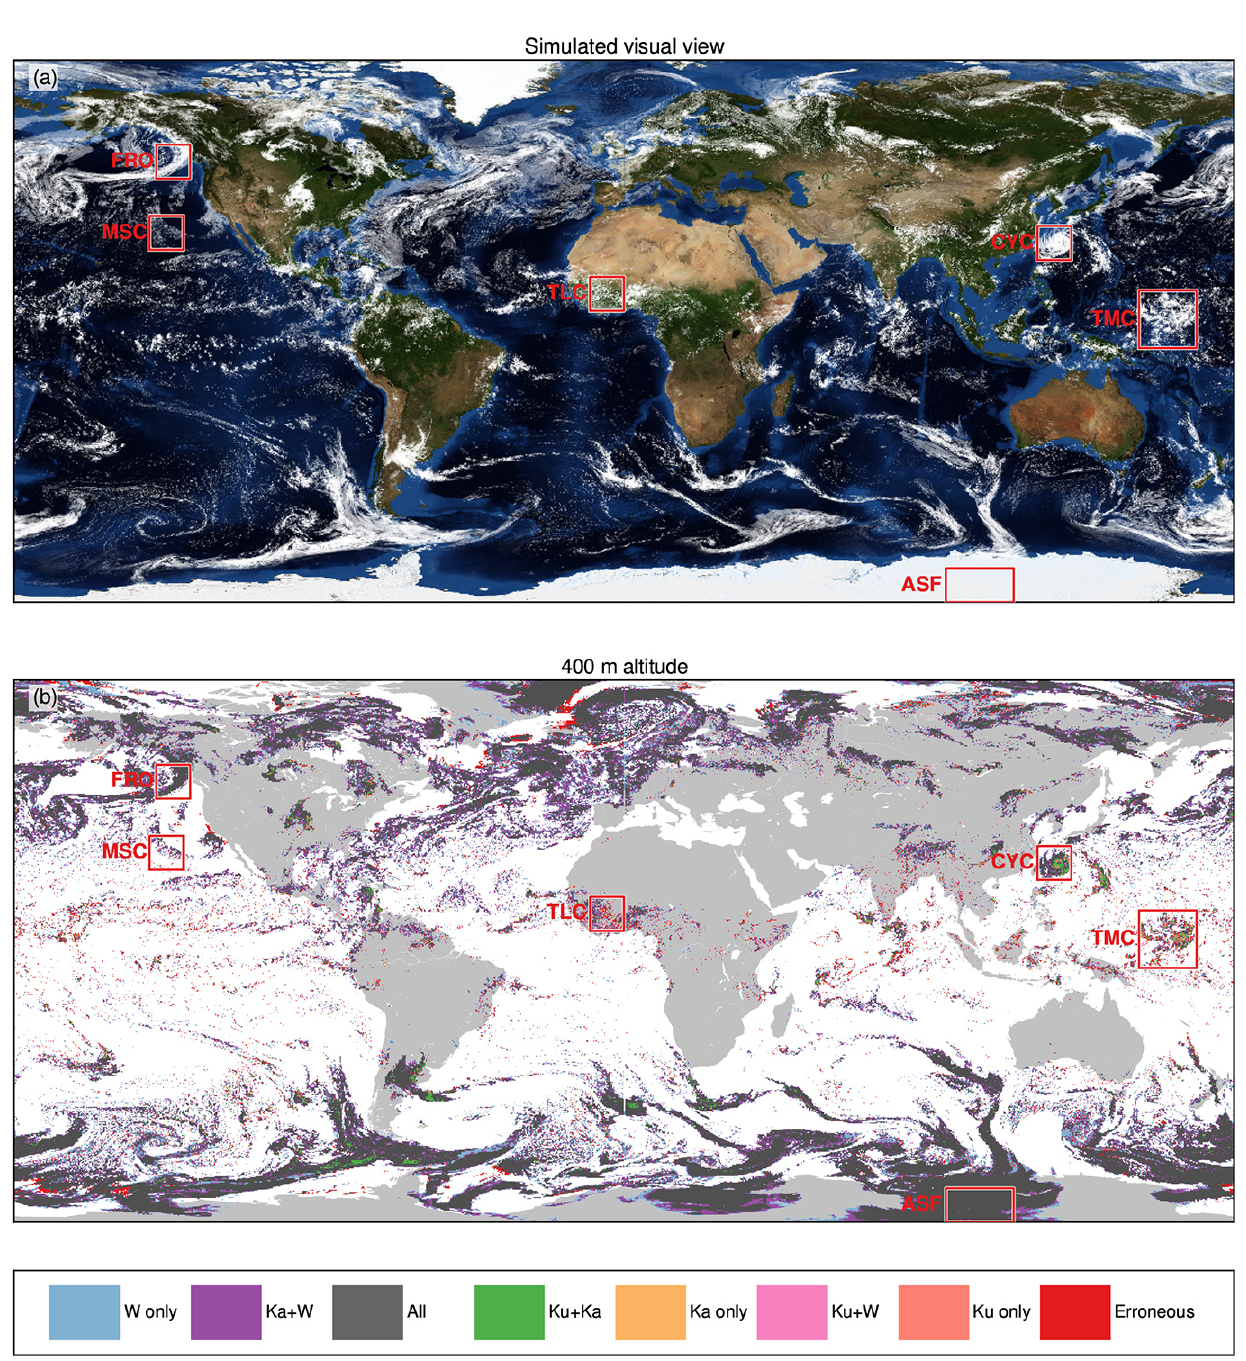
Figure 3. (a) A global overview of the clouds simulated by NICAM. Here, a simulated visual image of the clouds simulated by the model has been overlaid on the “blue marble” image of the Earth (by Reto Stöckli, NASA Earth Observatory). (b) A global map of detectability of the different radar bands at 400m above the surface, color coded as shown at the bottom of the figure. In both subfigures, the marked boxes denote the different case studies in Sect. 5: TMC, tropical maritime organized convection (Sect. 5.2); TLC, tropical overland convection (Sect. 5.3); CYC, tropical cyclone (Sect. 5.4); MSC, marine stratocumulus (Sect. 5.5); ASF, Antarctic snowfall (Sect. 5.6); FRO, midlatitude front (Sect.